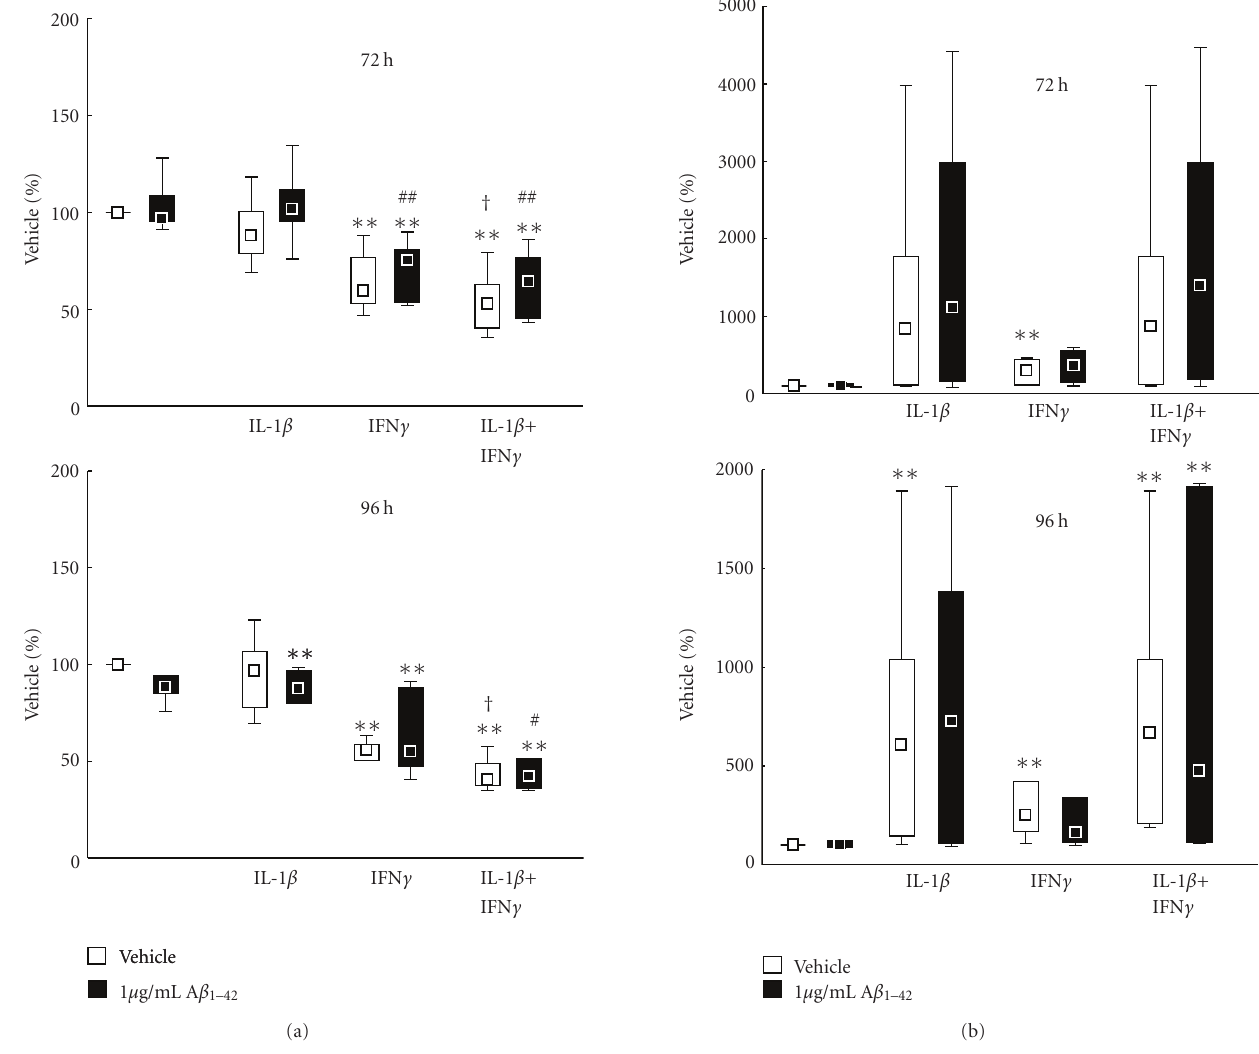
Figure 5: (a)-(b) E ff ects of incubation with interleukin-1 β (IL-1 β ) and interferon- γ (IFN γ ), added 24 hours before incubation with 1 μ g/mL A β 1 – 42 (black boxes) or vehicle (white boxes), on secreted levels of IL-6 (a) and BDNF (b) from CHME3 microglial cells. The cells were incubated with 1 μ g/mL HiLyte488-conjugated A β 1 – 42 following prestimulation for 24 hours with 50ng/mL IL-1 β and 50ng/mL IFN γ . The cells were harvested at 24, 48, 72, and 96 hours after addition of A β 1 – 42 . The data are expressed as % uptake of control vehicle set at 100% and shown as median ± percentiles (25%–75% and 10%–90%), n = 4 for 24 hours and 48 hours and n = 6 for 72 and 96 hours. A statistically significant e ff ect of treatment was found by Kruskal-Wallis ANOVA at 24 hours ( P = . 0087), at 72 hours ( P = . 004), and at 96 hours ( P = . 004). Statistical di ff erence from control is indicated by ∗∗ ( P < . 01); di ff erence from A β 1 – 42 # is indicated by ( P < . 05) and ## ( P < . 01). † indicates statistical di ff erence ( P < . 05) between IL-1 β and IL-1 β +IFN γ .